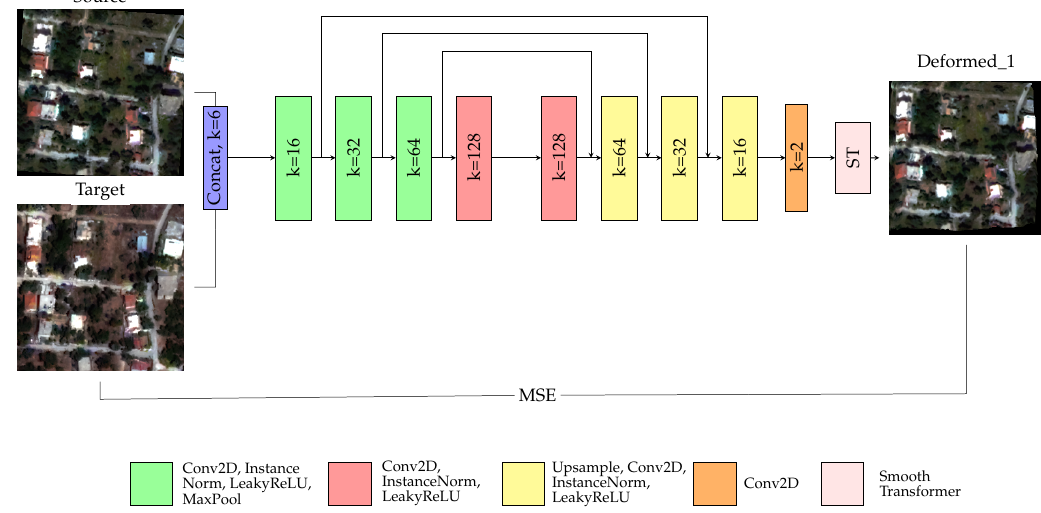
Figure 2. Overview of the proposed fully convolutional network employed during the first time step. The concatenation of the source image S and the target image R is given as input to the